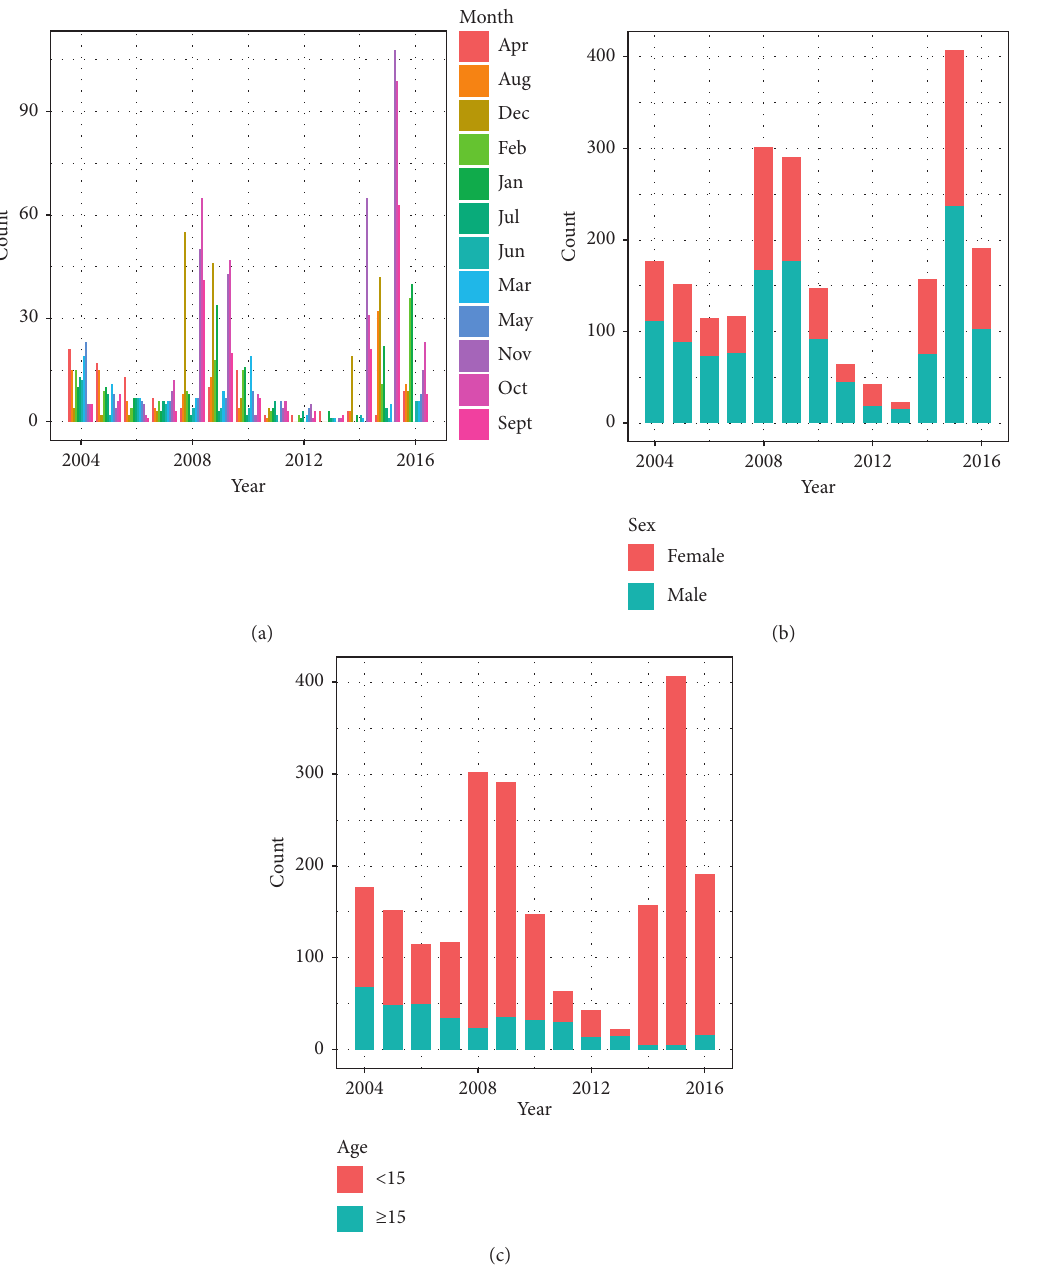
Figure 1: The data of human leishmaniasis cases from 2004 to 2016. (a) The reported data are described at different years. (b) The reported data are described at different genders and (c) different ages from 2004 to